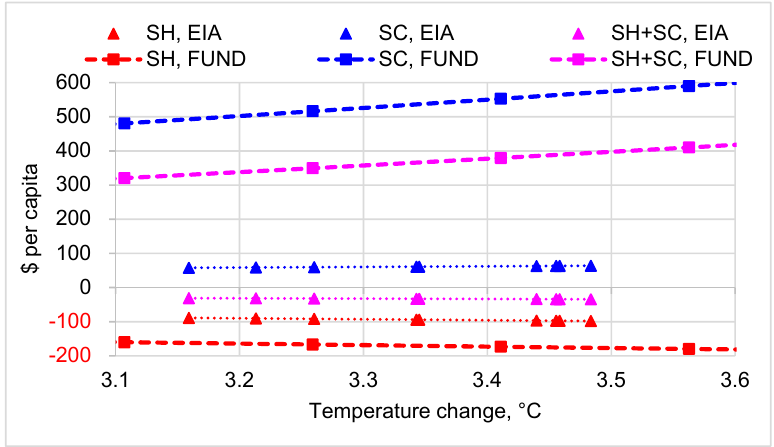
Figure 14. Impact of 3 ◦ C GMST increase on US space heating and space cooling per capita energy expenditure versus temperature change at latitude 30 ◦ N to 45 ◦ N from the analysis of the EIA data, and from projections with non-temperature drivers at 2010